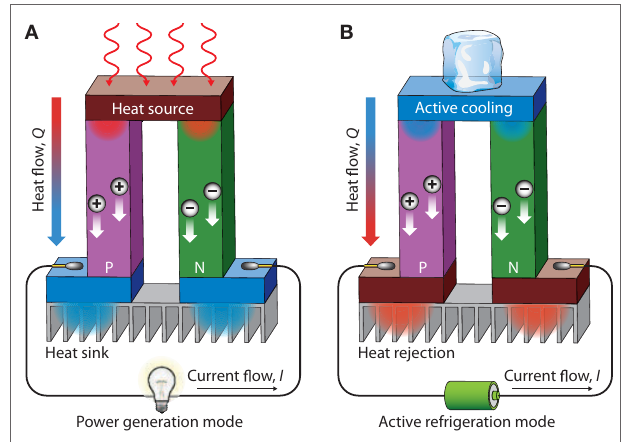
FiGURe 13 | Schematic illustration of a thermoelectric module for (A) power generation (seebeck effect) and (B) active generation (Peltier effect) . Reproduced with the Permission from Li et al. (2010d). Copyright 2010, NPG Asia